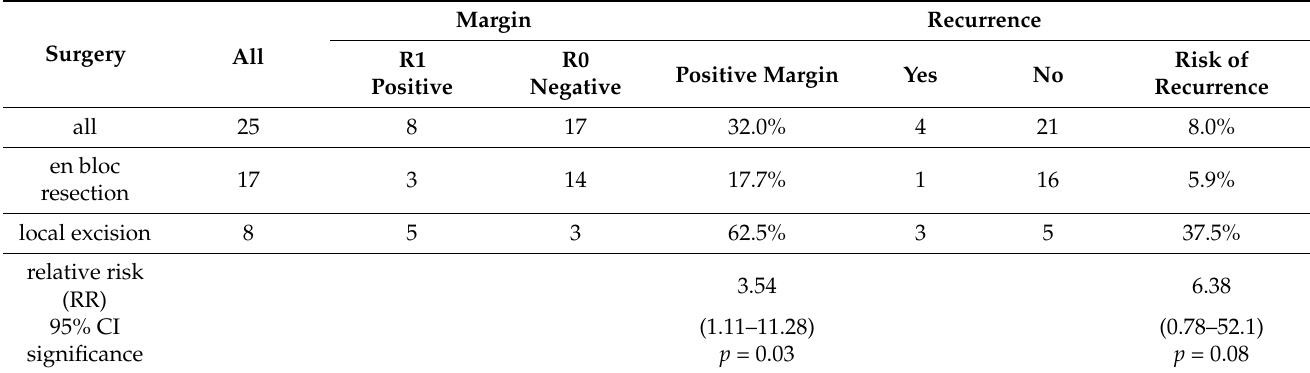
Table 3. Initial surgery: resection choice predicts margin status and recurrence.